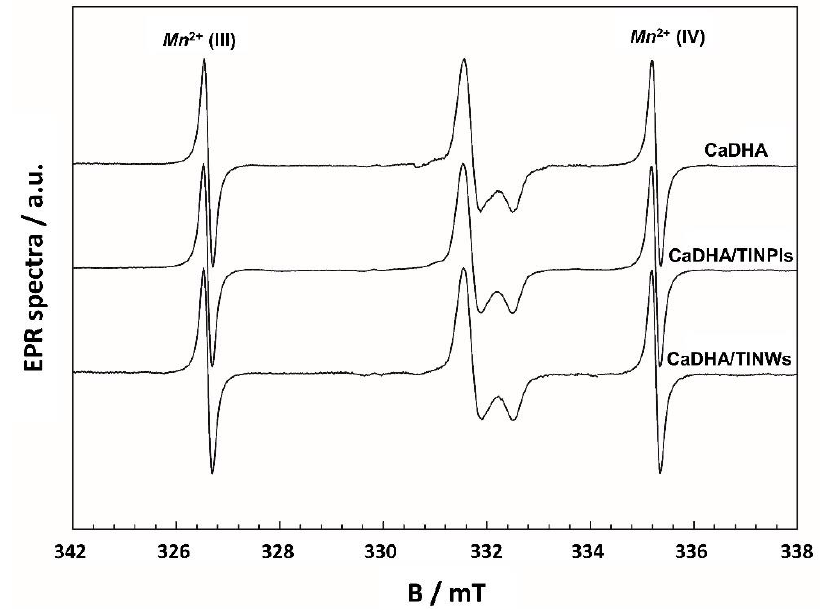
Figure 8. Experimental EPR spectra of gamma-irradiated precipitates formed after 60 min reaction time in the control system (calcium deficient hydroxyapatite, CaDHA) and the presence of 100 mg L − 1 TiO 2 nanoplates (CaDHA/TiNPls), and nanowires (CaDHA/TiNWs). Two satellite lines on the left and right side are the third and fourth lines of the Mn 2+ /MgO internal standard.